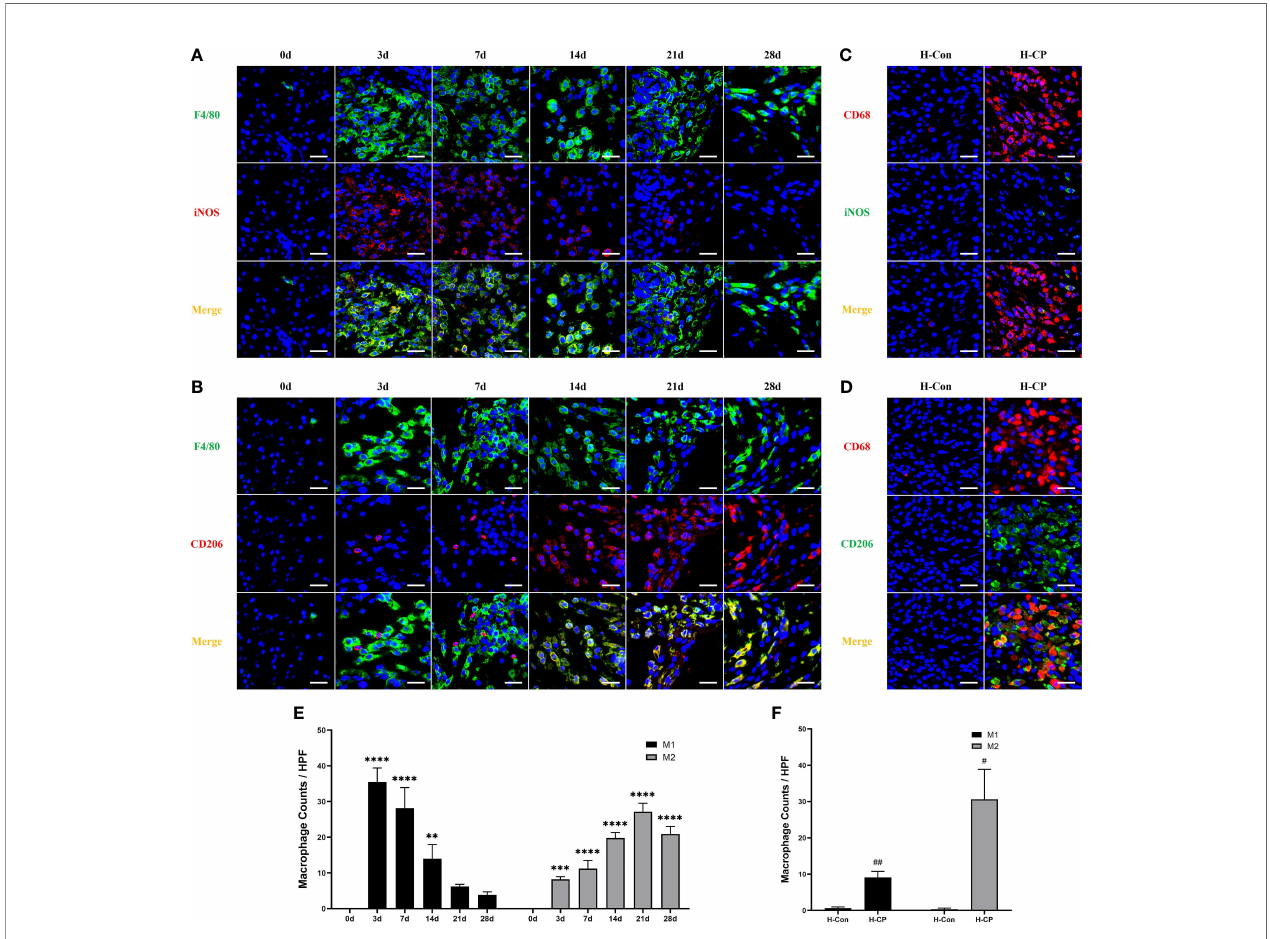
FIGURE 5 | The subtype of macrophages changes when AP shifted to CP. In AP (3d) and the early phase of CP (7d), macrophages were predominantly M1 subtype (F4/80+iNOS+ cells). From 14d onwards, it was the M2 subtype (F4/80+CD206+ cells) of macrophages that was predominant, which was peaked at 21d. For human CP specimens, the pancreatic in fi ltrating macrophages were also predominantly M2 subtype (CD68+CD206+ cells) rather than M1 (CD68+iNOS+ cells) subtype. (A, B) Immuno fl uorescence staining of pancreatic in fi ltrating M1 and M2 macrophages in mice model of pancreatitis at different time points. (C, D) Immuno fl uorescence staining of pancreatic in fi ltrating M1 and M2 macrophages in human specimens. (E) Pancreatic M1 and M2 macrophage counts per HPF in mice. (F) Pancreatic M1 and M2 macrophage counts per HPF in human specimens. Values are shown as means ± SE. n = 3 per group. **P < 0.01, ***P < 0.001, ****P < 0.0001 versus 0d. # p < 0.05, ## p < 0.01 versus H-Con. Scale bar=20 m m. H-CP, human chronic pancreatitis; H-Con, human control; HPF, high-powered fi eld of